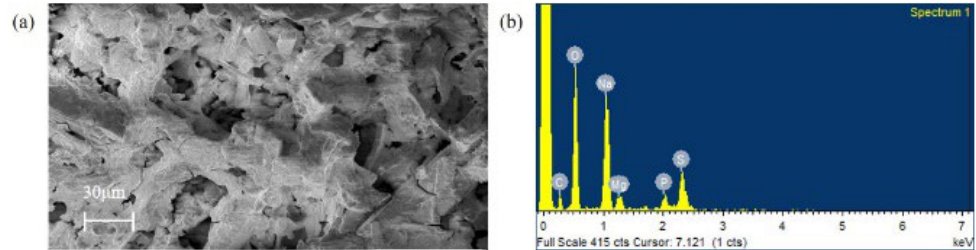
Figure 2. ( a ) (Left) scanning electron micrograph of exopolysaccharide (EPS) with a voltage of 10 kV under image magnification of 500× X. ( b ) SEM–EDX spectrum of exopolysaccharide